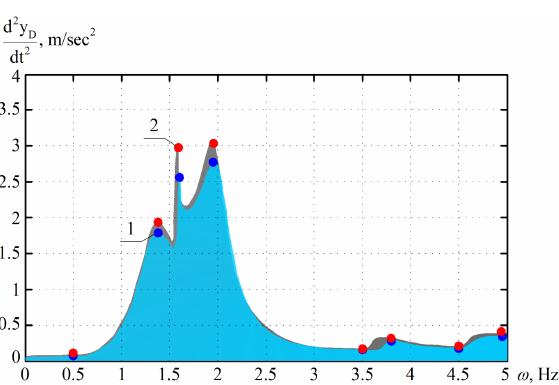
Fig. 3. Amplitude-frequency characteristics of vertical accelerations driver’s seat: 1 – liquid cargo; 2 – solid cargo At the average frequencies (from 3 to 16 Hz) the change of tractor frame accelerations ( Fig. 2 ) varies between 20 % and 50 %, and for the vertical accelerations of the driver’s seat ( Fig. 3 ) it is from 7 % to 20